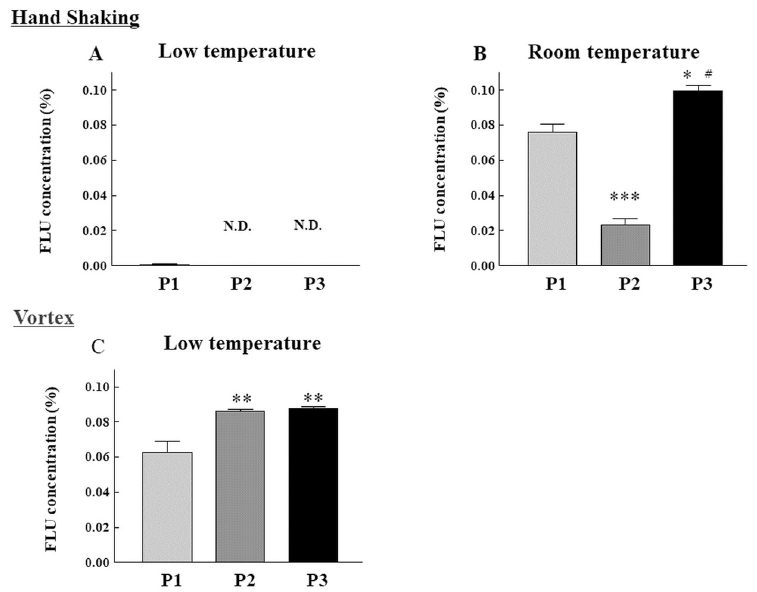
Fig 6. Changes in the concentration of FLU ophthalmic suspensions contained in one drop following agitation by different methods. In the low (left panel) and room (right panel) temperature groups, each formulation of 0.1% FLU ophthalmic suspension was stored at 10˚C for three months and subsequently maintained at room temperature for two months or left at room temperature for five months. The concentration of FLU suspensions contained in one drop from each formulation was measured by HPLC after agitation by hands (A, B) or using a vortex mixer (C). P1; Original, P2; Generic A, P3; Generic B, N.D.; not detected. n = 3, ��� p < 0.001, �� p < 0.01, � p < 0.05 vs. Original, ### p < 0.001 vs. Generic A. All data are expressed as mean ± standard deviation and were analyzed by one-way analysis of variance followed by Tukey’s test.